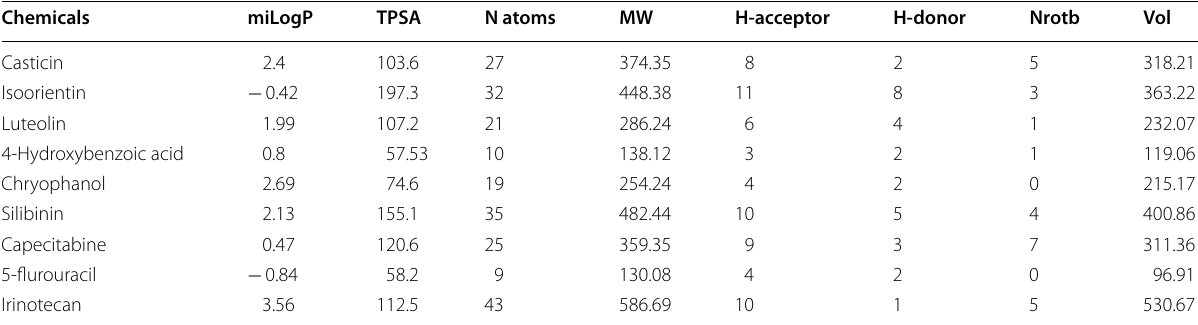
Table 1 Pharmacophore properties of selected compounds based on Lipinski Rule of 5 and Veber’s Rule